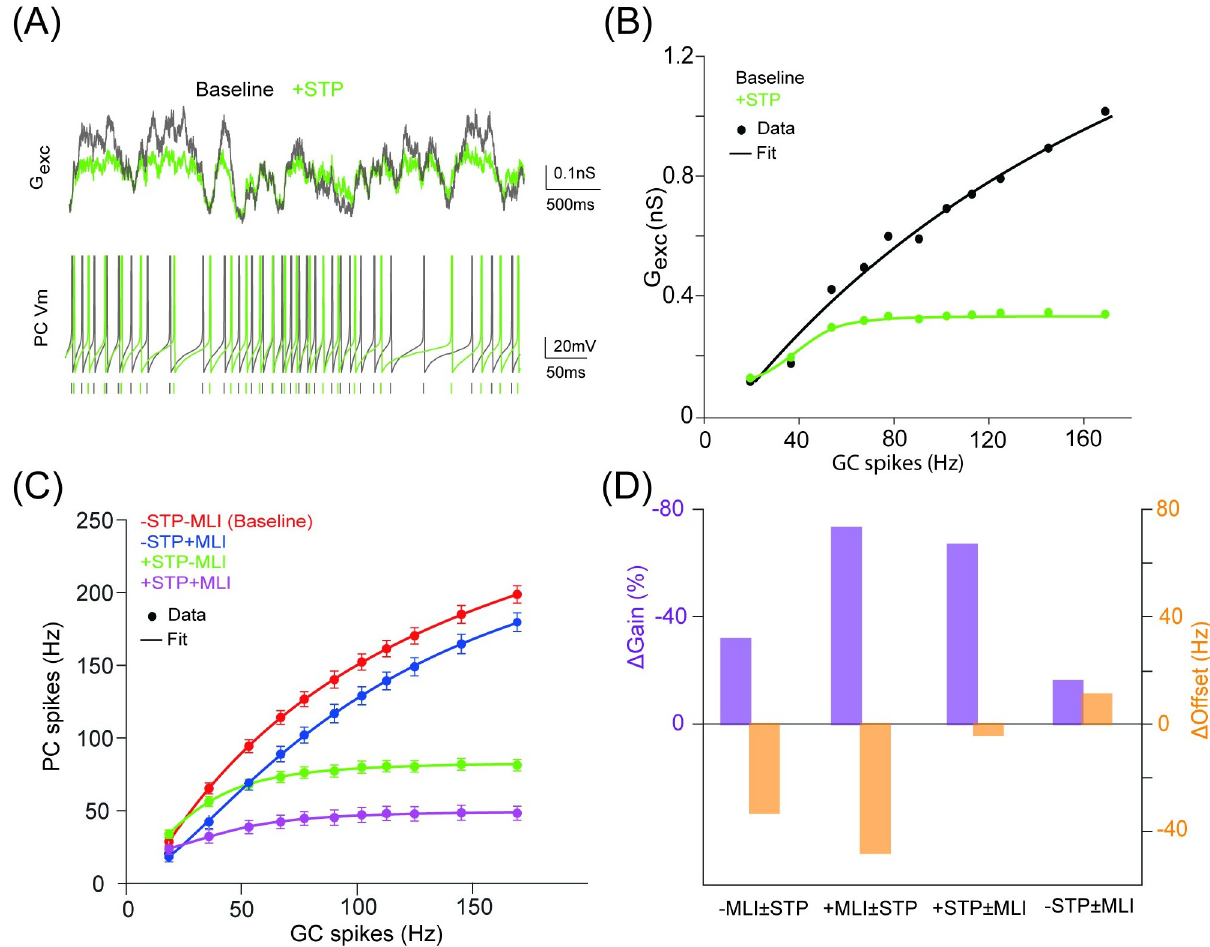
Fig 2. Inhibition-mediated gain modulation of PC firing dynamics enhanced by excitatory short-term plasticity. (A) (Top) Sum of excitatory conductance G exc onto a PC in the baseline condition (STP off) and a test condition with STP. The input is 100 independent synaptic trains using Poisson stimulation at 50 Hz. (Bottom) PC membrane potential traces with and without STP. Vertical ticks indicate spike times. (B) Average G exc changing over a range of GC rates with and without STP. G exc was averaged over the time course and all GCs connected to a PC. (C) PC input-output relationship in four conditions, with/without STP and/or MLI. Each point is mean ± SD (n = 50). Poisson stimulation was used. Lines in (B) and (C) are fits to a Hill function. (D) Heterogeneous gain and offset changes due to STP ( ± STD) and MLI ( ± MLI) from fits in (C).